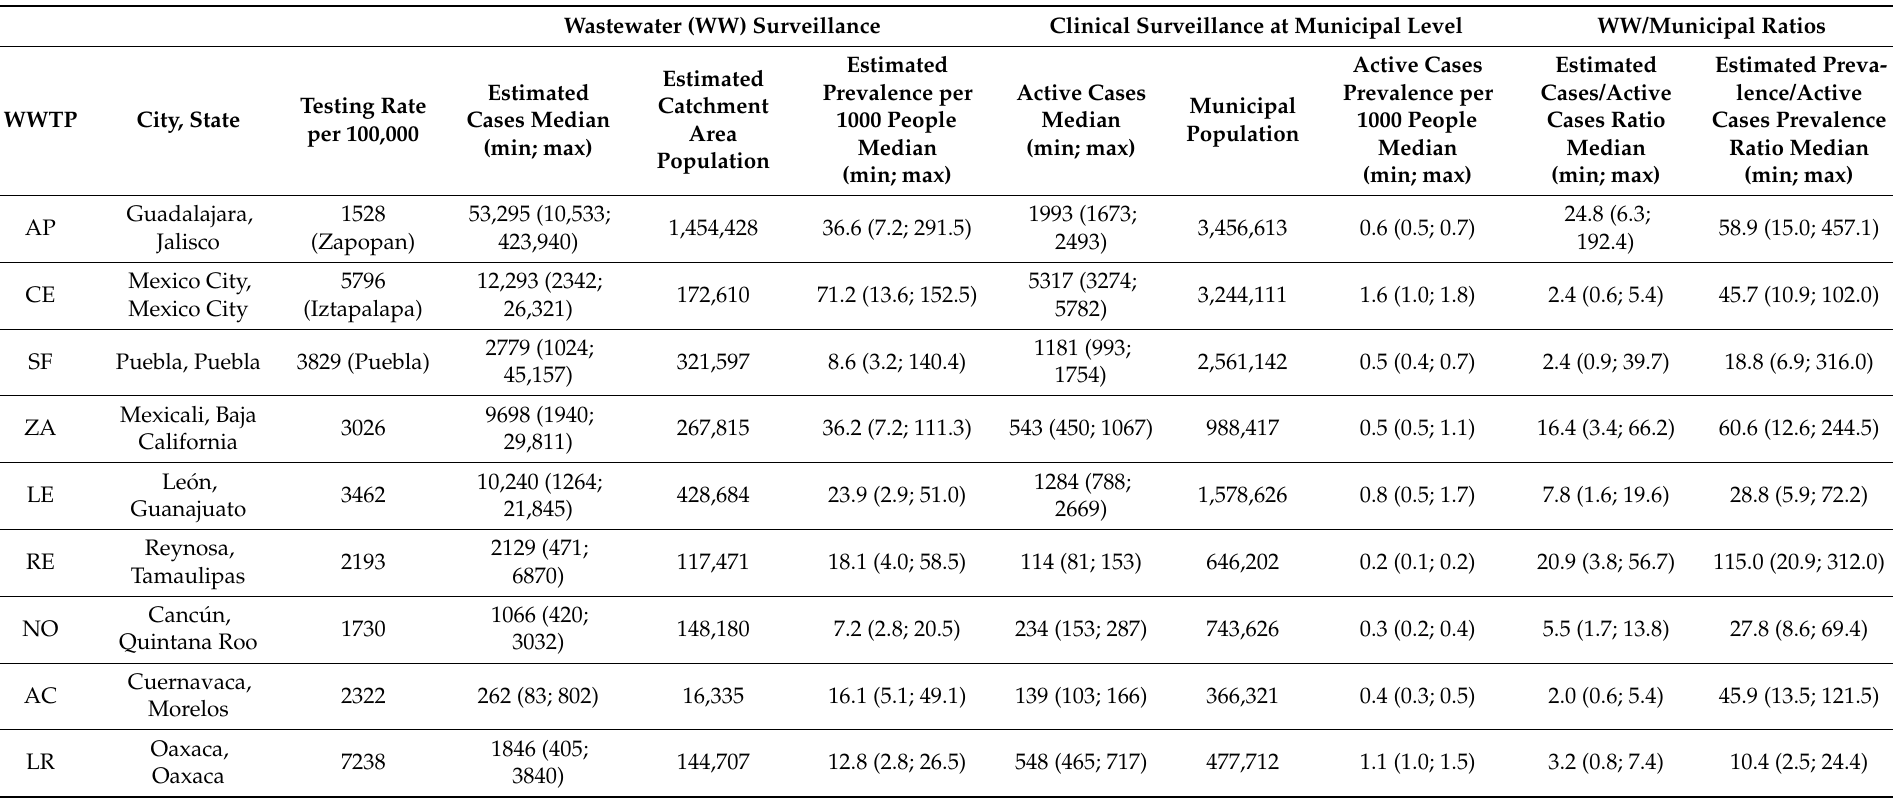
Table 3. WW-based estimated cases, catchment area population, and prevalence, compared to clinical-based active cases, municipal population, and prevalence for the period October–November 2020 in